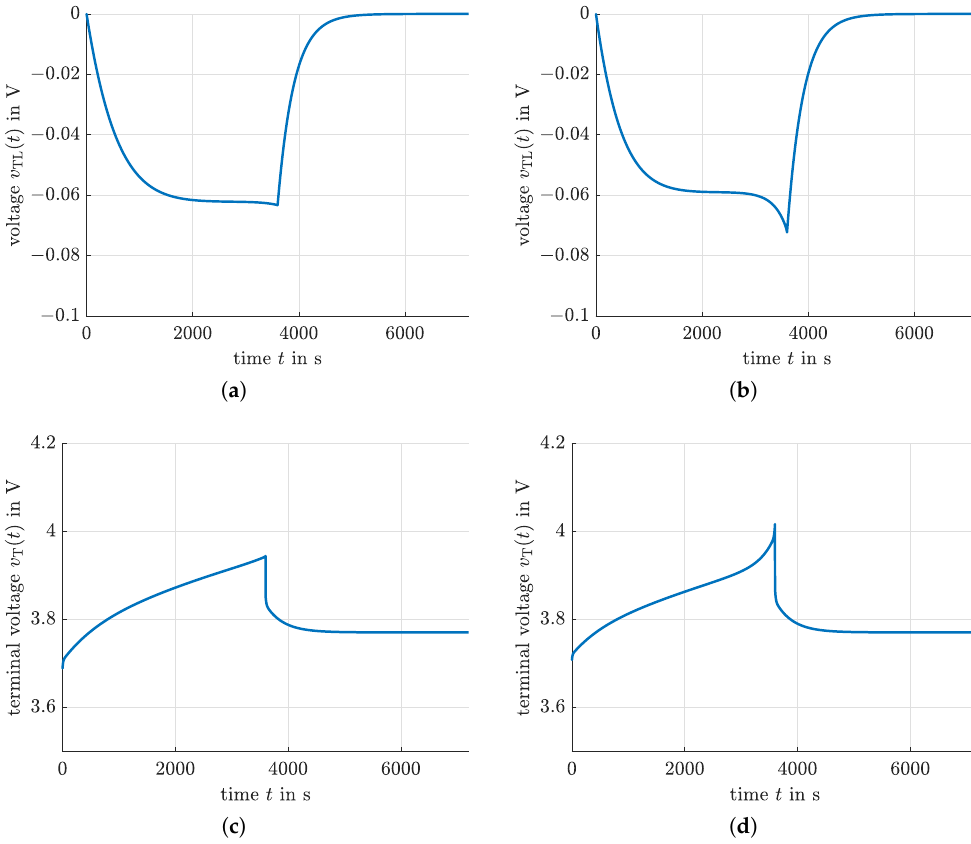
Figure 6. Offline optimization of the charging profile according to Section 3.1.2 (continued). ( a ) Volt- age v TL ( t ) for α = 1; ( b ) Voltage v TL ( t ) for α = 0.01; ( c ) Terminal voltage v T ( t ) for α = 1; ( d ) Terminal voltage v T ( t ) for α = 0.01.